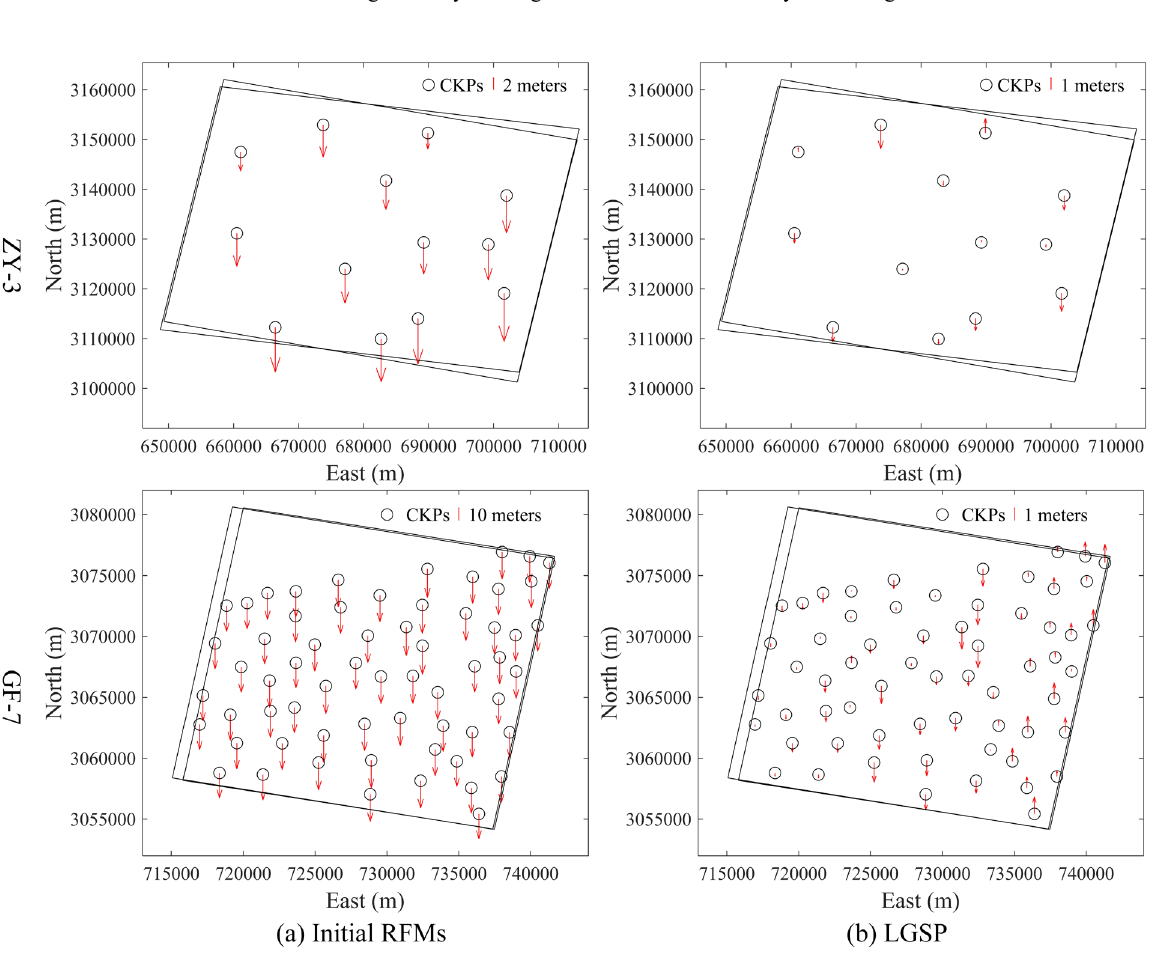
Figure 6. Distribution diagram of height errors of satellite stereo